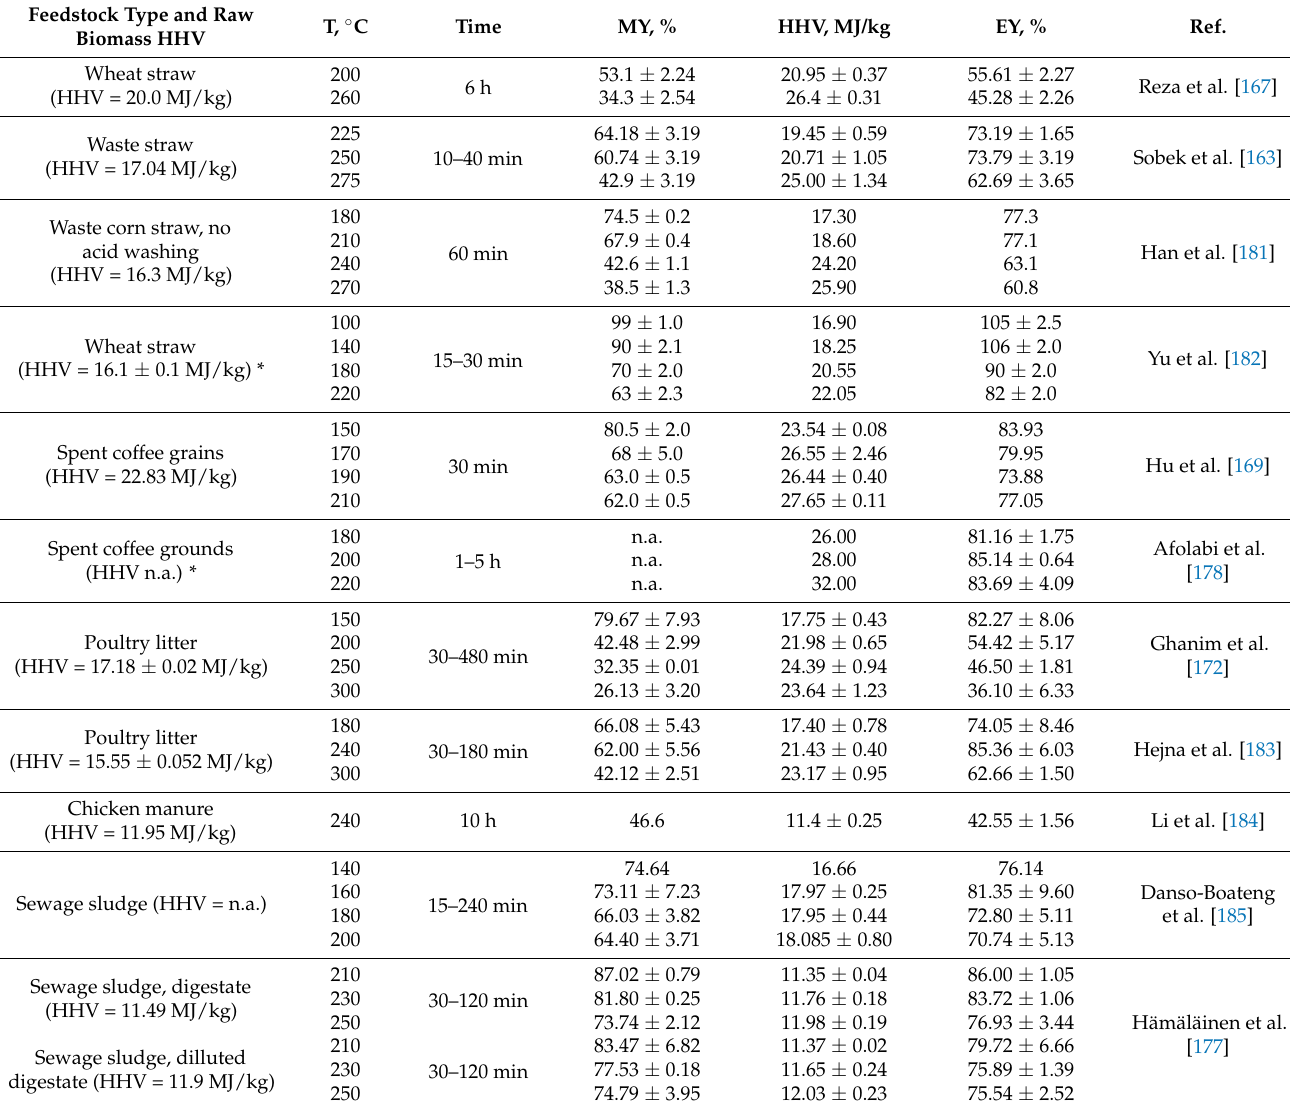
Table 3. Impact of process parameters on higher heating value and energy yields of the hydrochars from hydrothermal carbonization of different biomass